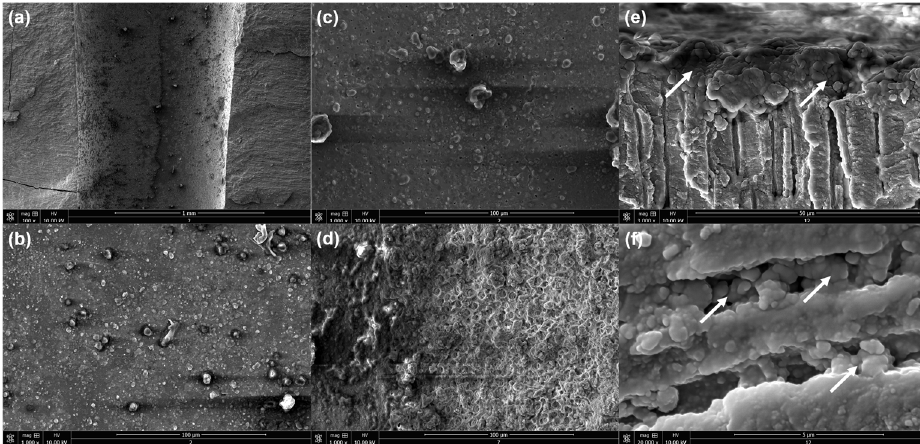
Figure 4. SEM images demonstrate ( a , b ) closed dentinal tubules; ( c , d ) partially opened dentinal tubules; ( e ) remaining calcium silicate sealer on the root canal walls; ( f ) dentinal tubules filled with mineral components (white arrows).